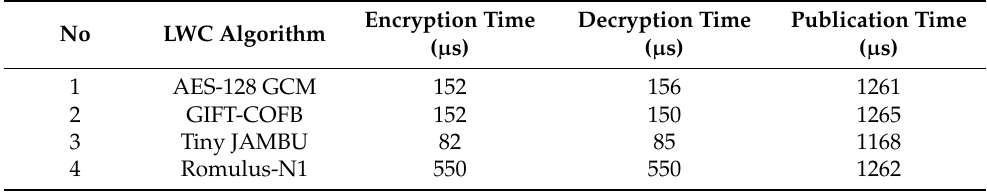
15 Characters Messages Used Anonymous